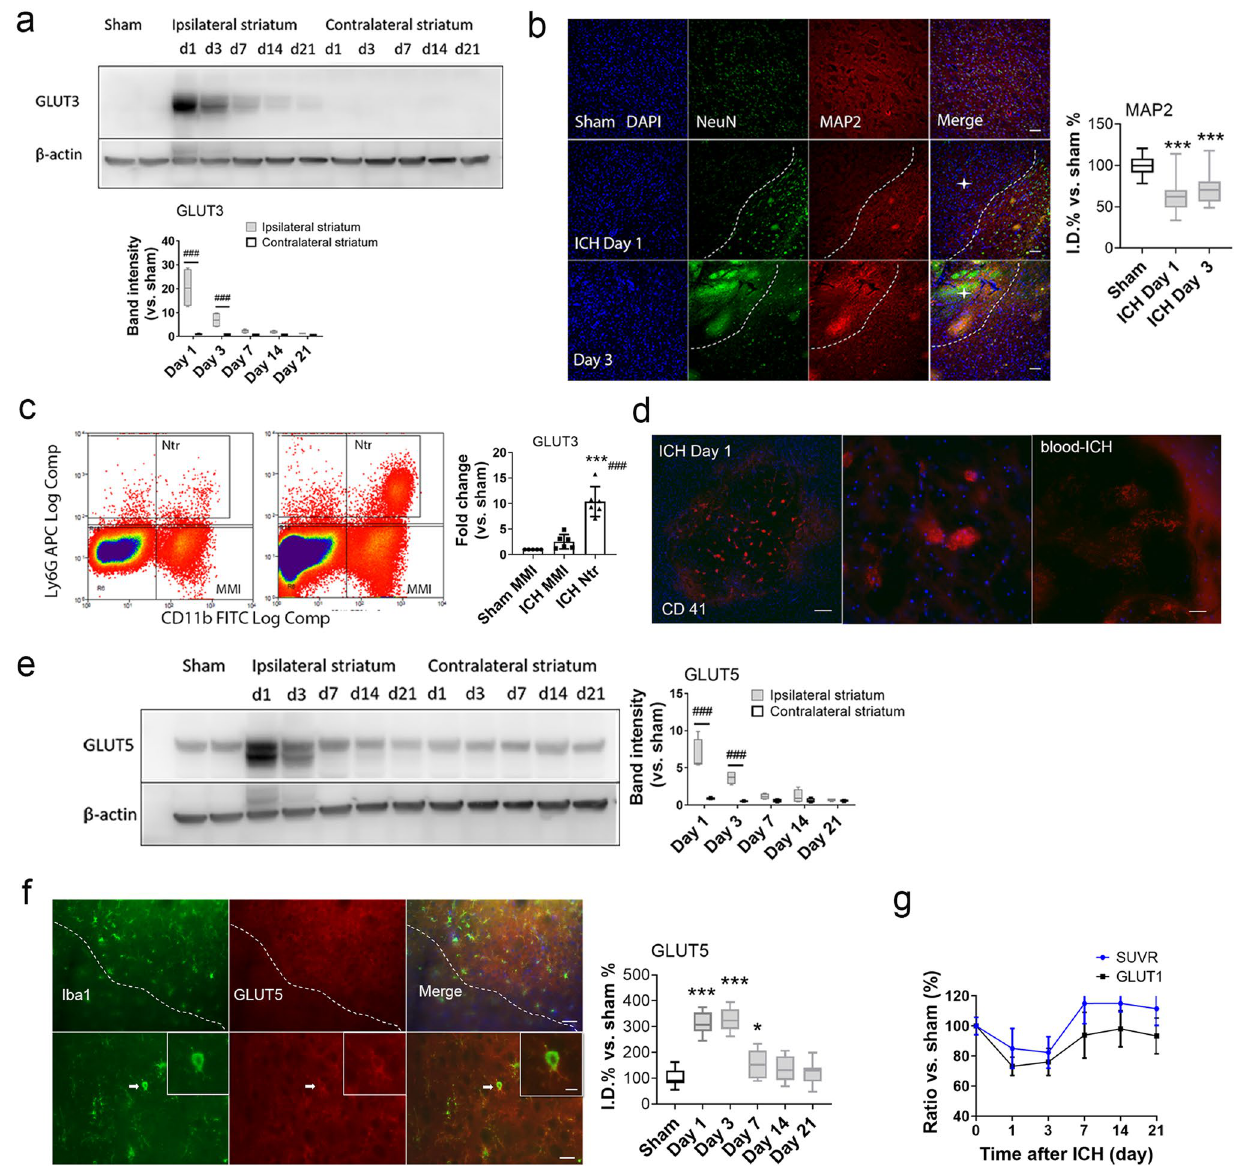
Figure 4. Expression of GLUT3 and GLUT5 increases in the ipsilateral striatum after ICH. ( a ) Representative Western blot (left) and quantification of GLUT3 expression (right) in striatum after ICH. n = 4/group. ### p < 0.001. Two-way ANOVA with Bonferroni post hoc test. The membrane was cut before it was hybridized with GLUT3 antibody according to molecular weight of GLUT3. Raw images of the blots are presented in Supplementary Fig. 3. ( b ) Representative images and quantification of MAP2 expression in the ipsilateral striatum on days 1 and 3 after ICH. Scale bar: 50 µm. Stars in the outlined areas indicate the hemorrhagic core. n = 5/group; *** p < 0.001; one-way ANOVA with Bonferroni multiple comparison test. ( c ) Representative gating of CD11b-FITC + / Ly6G-APC + neutrophils and CD11b-FITC + / Ly6G-APC - MMI and fold change of GLUT3 mRNA in cells at day 1 after ICH. n = 4, *** p < 0.001 versus sham MMI. ###p < 0.001 versus ICH MMI. Ntr, neutrophils; MMI, macrophage/microglia. ( d ) Representative images of CD41 expression in the ipsilateral striatum on day 1 after collagenase-induced ICH and autologous blood- induced ICH. Red: CD41. Blue: DAPI. Scale bar: left 100 µm; right 25 µm. ( e ) Representative Western blot (left) and quantification of GLUT5 expression (right) in striatum after ICH. n = 4/group. ### p < 0.001. Two-way ANOVA with Bonferroni post hoc test The membrane was cut before it was hybridized with GLUT5 antibody according to molecular weight of GLUT5. Raw images of the blots are presented in Supplementary Fig. 3. ( f ) Brain sections were immunostained for Iba1 (green) and GLUT5 (red) to characterize microglia in the perihematomal region on day 3 after ICH. The area outlined in the lower left corner indicates the hematoma core. The arrow in the lower panel indicates one microglia under higher magnification. Insets show the same microglia under higher magnification. Scale bar: upper panel, 50 µm; lower panel, 25 µm; inset, 10 µm. Graph shows the quantification of GLUT5 expression in the ipsilateral striatum at multiple time points after ICH. n = 5/group. * p < 0.05, *** p < 0.001 versus sham group. ( g ) Comparison of standardized uptake value ratio on PET scan and relative GLUT1 level evaluated by Western blotting in the ipsilateral striatum at the indicated times after ICH. Pearson correlation test. Correlation coefficient r = 0.845, p = 0.034. Data are presented as mean ± SD at each time